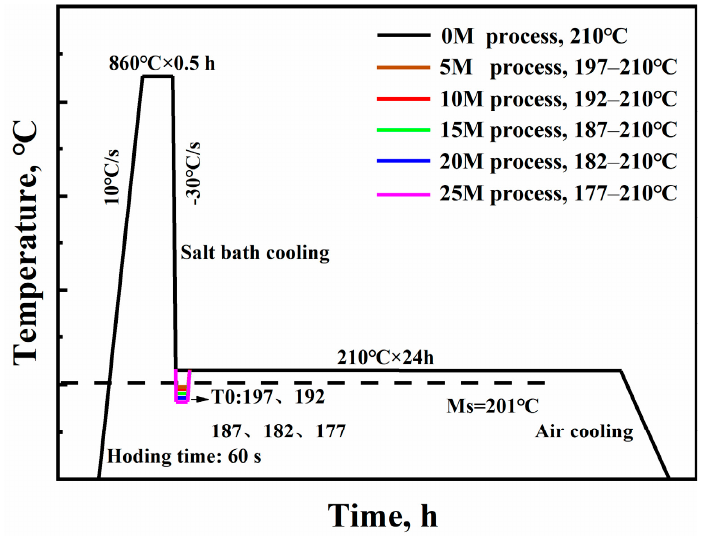
Figure 1. Heat treatment process of test steel.